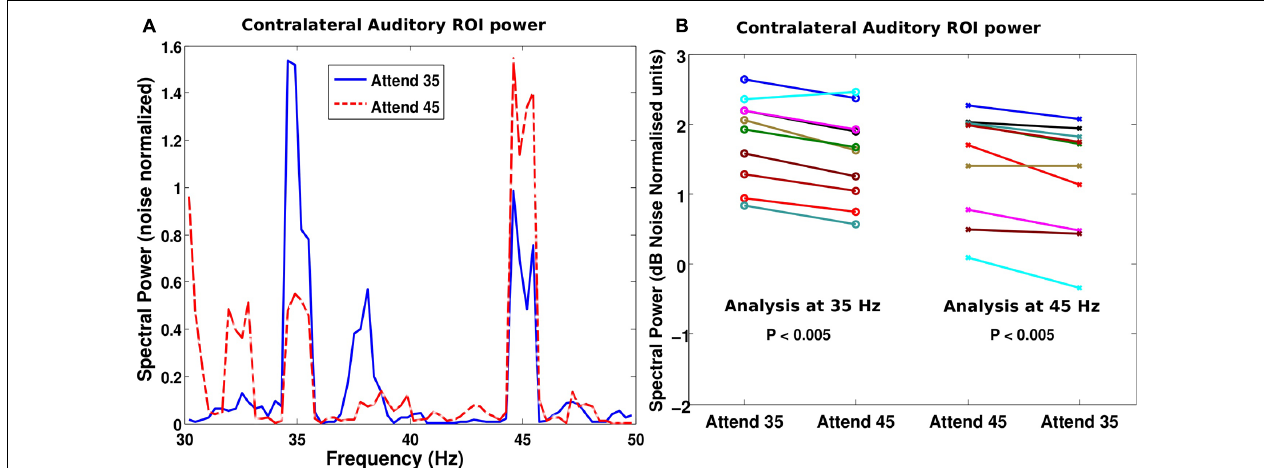
were seen across our cohort of subjects.The spectral power at 35 Hz is plotted on the left half of the panel (open circles denoting individual subject values) and the spectral power at 45 Hz is plotted on the right half (crosses for individual subject values).When the subject attended to the stream modulated at 35 Hz, the 35 Hz power is higher for most subjects than when they attended to the 45 Hz stream. Similarly, the 45 Hz power was higher when the subjects attended to the 45 Hz stream rather than the 35 Hz stream.The effect, though small, was robust and consistent across